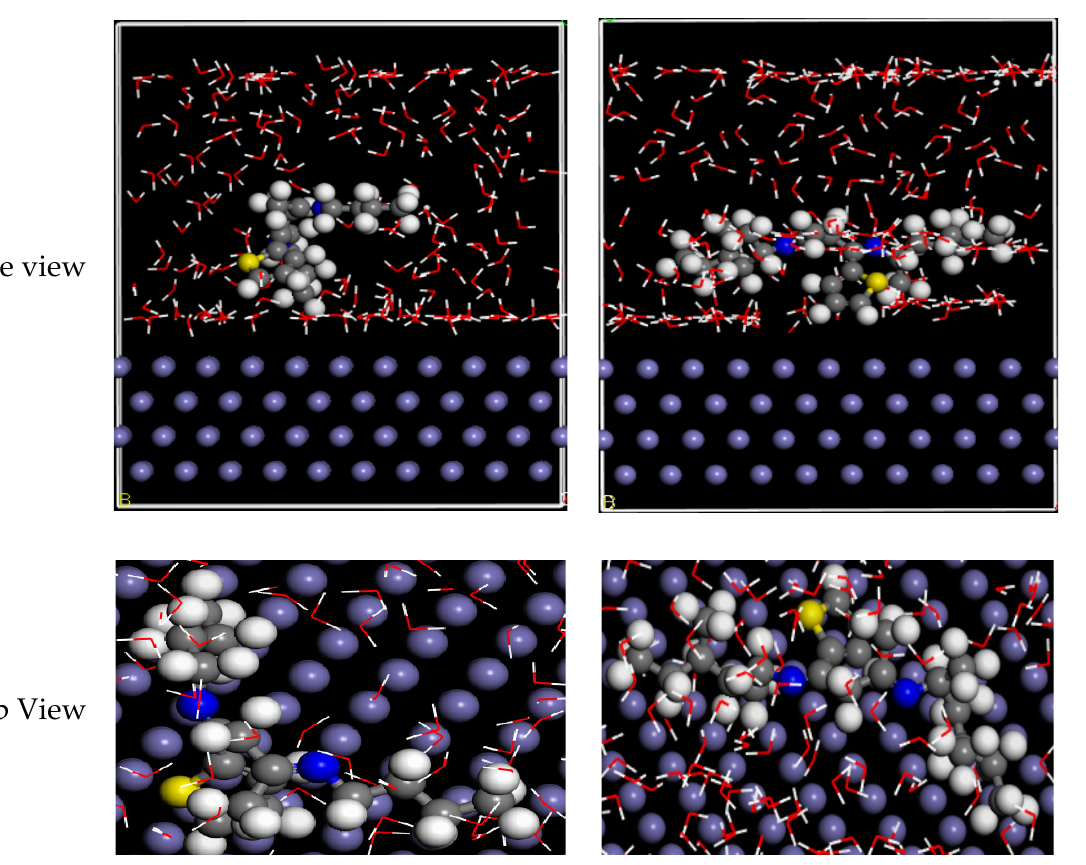
Table 6. Interaction energy and binding energy values between the inhibitors and Fe(110) surface.